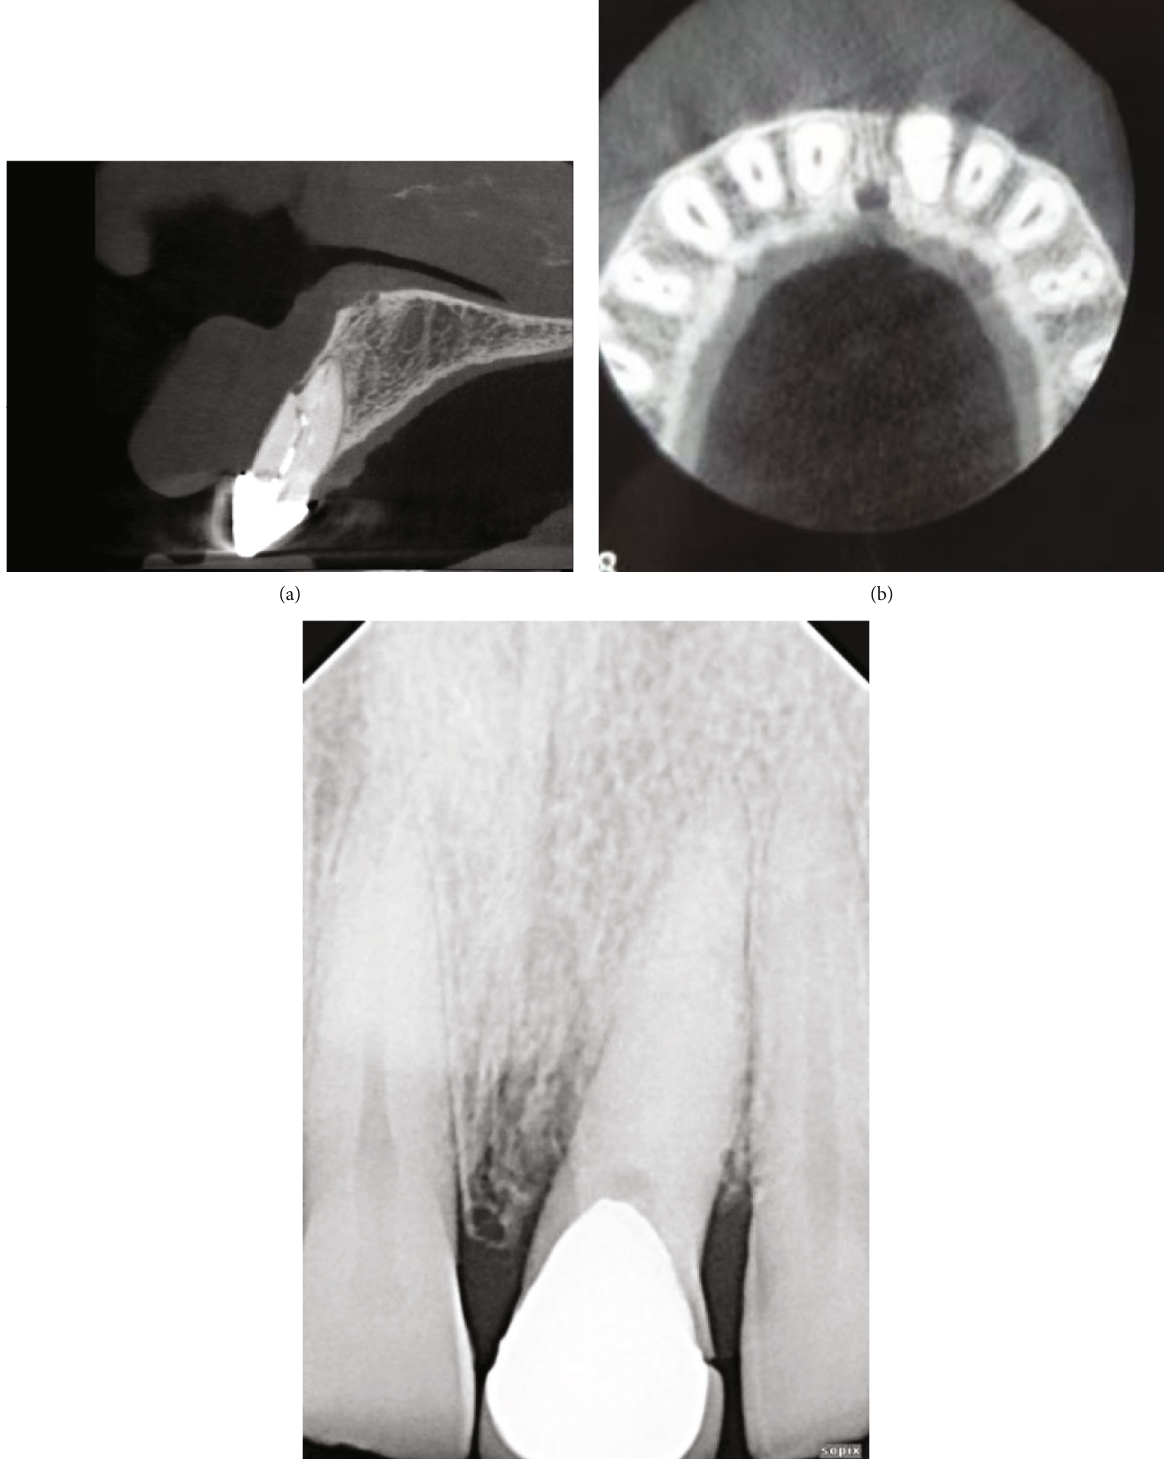
Figure 7: (a) After 1 year of follow-up (axial view). (b) One year of follow-up (sagittal view). (c) One year of follow-up on